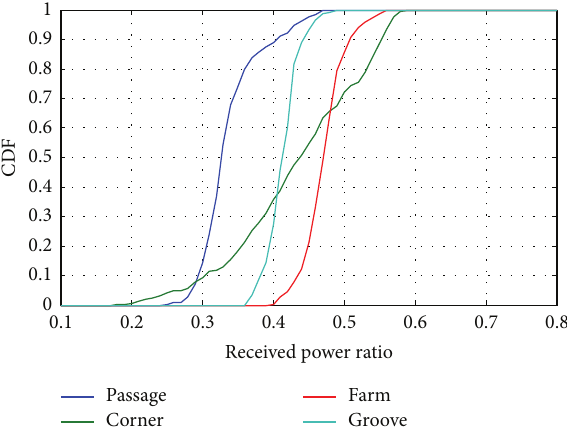
Figure 11: Distribution plot for received power ratio.